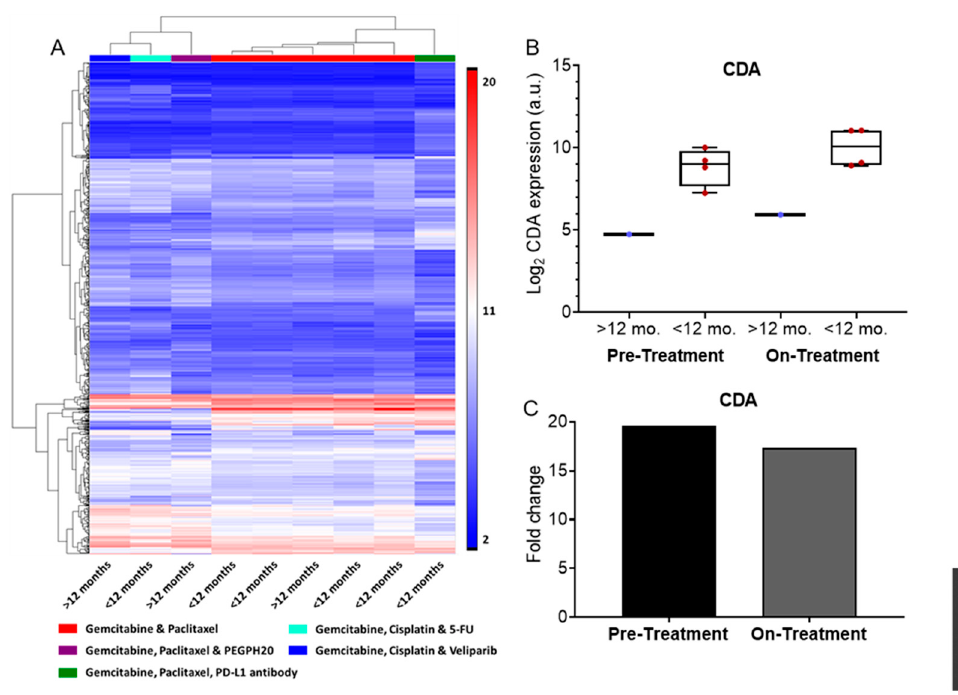
Figure 5. Effect of treatment on CTC transcriptome from on-treatment samples. ( A ) Hierarchical clustering of on-treatment CTC samples. Treatment is denoted with the colored bars at the top and patient status is shown below. ( B ) Log2 expression of CDA for patients received gemcitabine and paclitaxel therapy. ( C ) Fold change in expression of CDA based on survival <12 months and survival > 12 moth at each time point for patients received gemcitabine and paclitaxel therapy.